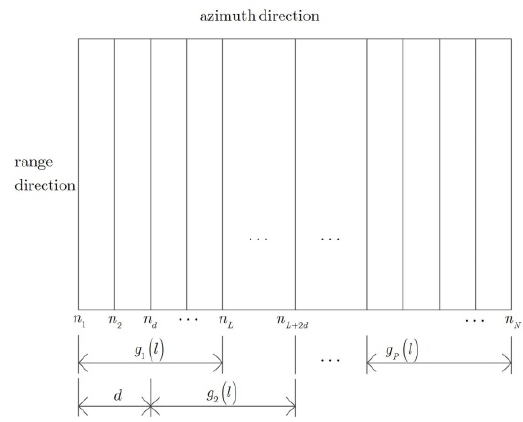
Figure 3. Subarray averaging technique schematic diagram.